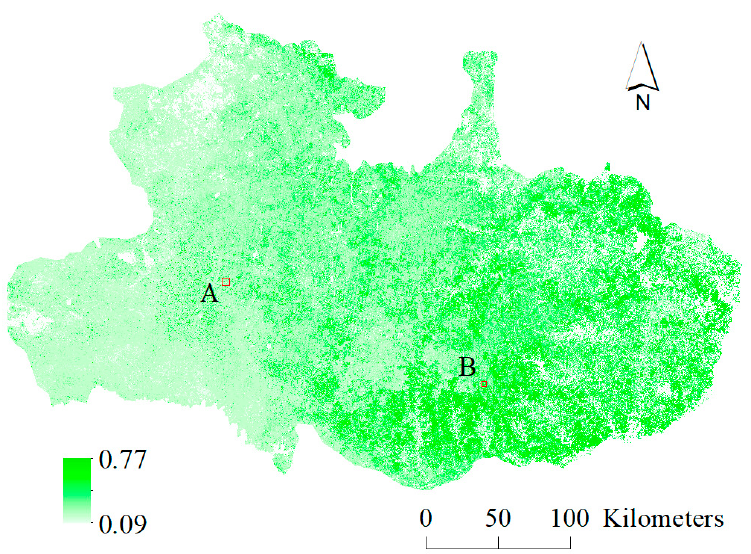
Figure 4. Fractional woody cover map of Texas savanna at 30 m scale.